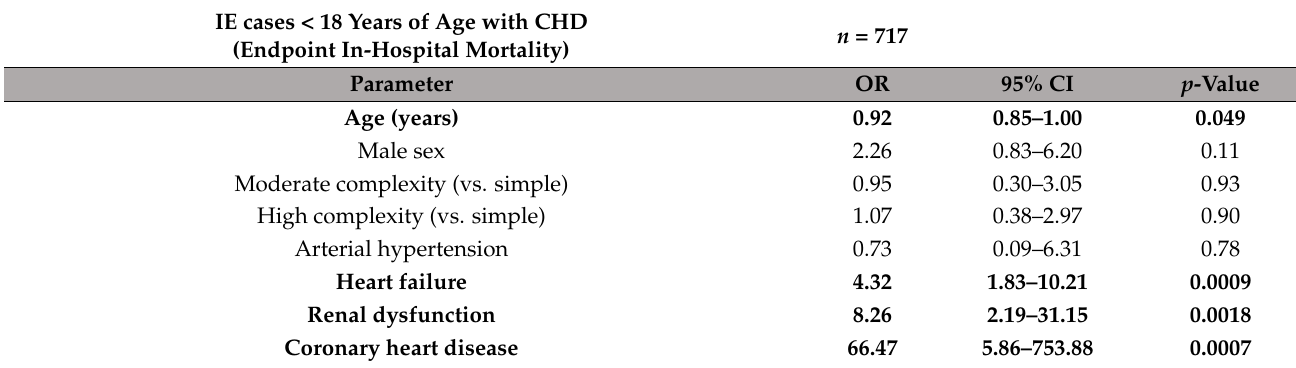
Table 5. Association between age, sex, disease complexity and co-morbidities, and death specifically in paediatric con- genital heart disease patients with infective endocarditis. IE = infective endocarditis; CHD = congenital heart disease; CI = confidence interval; OR = odds ratio. Significant variables are in